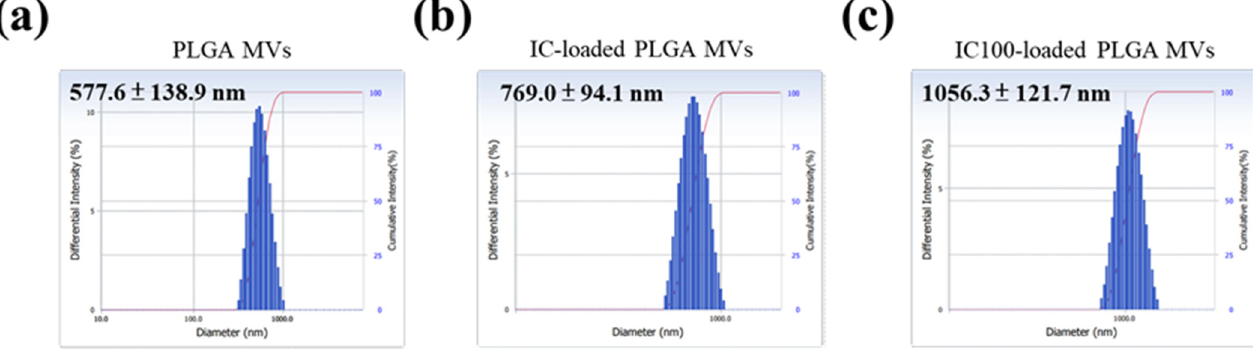
Figure 4. Optical characterization of PLGA MVs and IC ‐ loaded PLGA MVs.